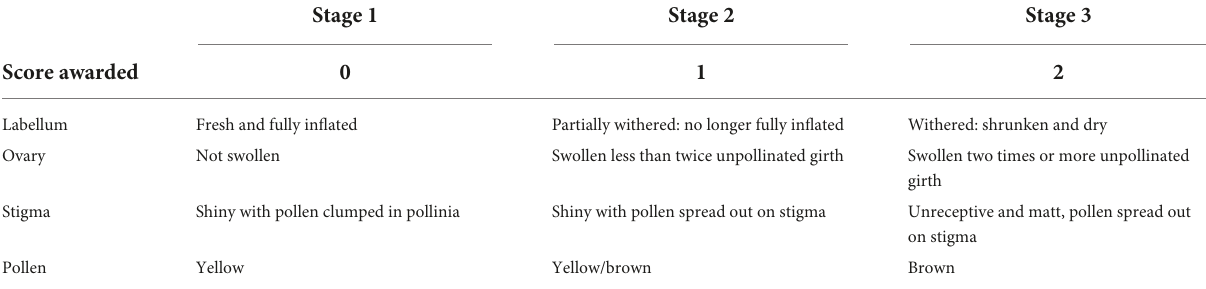
TABLE 2 Description of the pollination stages of the labellum, ovary, stigma, and pollen that were used to assess degree of post-pollination withering, and the corresponding post-pollination scores awarded. Stage 1 Stage 2 Stage 3